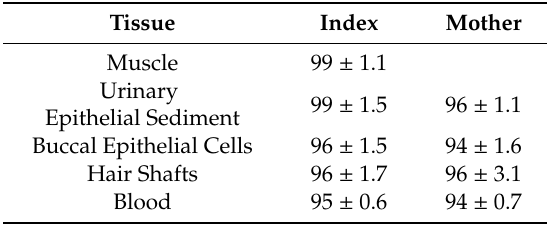
Table 1. Segregation study to determine the level of mtDNA heteroplasmy (%) of the novel MT-ATP6 variant in the index patient and mother; values given as means (%) by triplet-analysis +